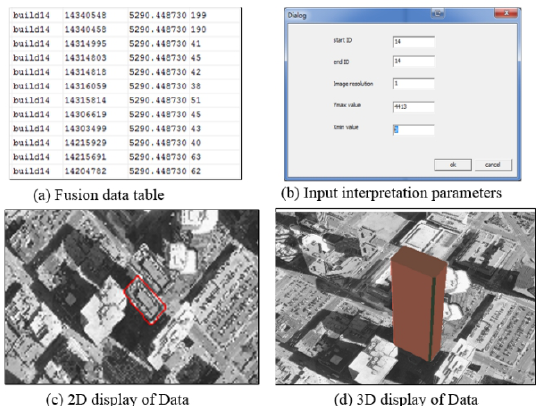
Figure 9. Schematic diagram of use the fusion